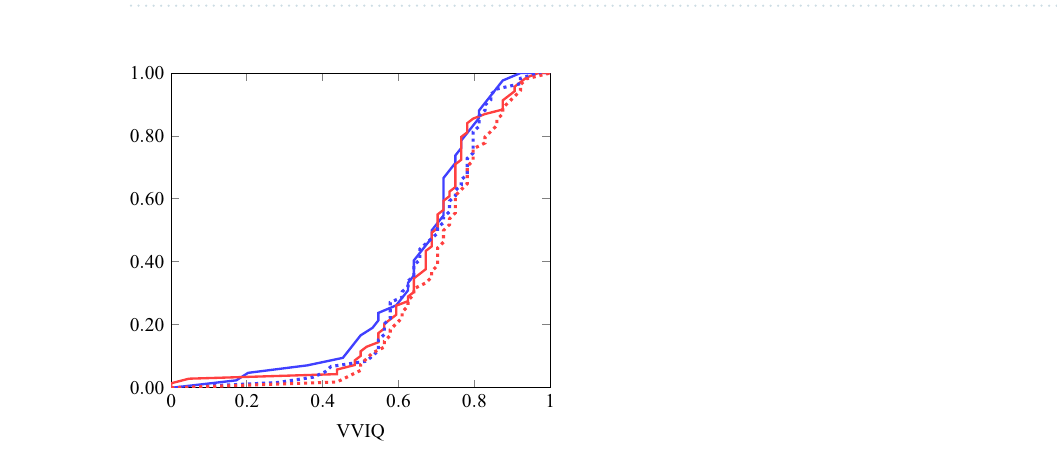
Figure 3. Cumulative distributions of RA for the non-visual (solid) and visual (dotted) treatments for males (blue) and females (red).